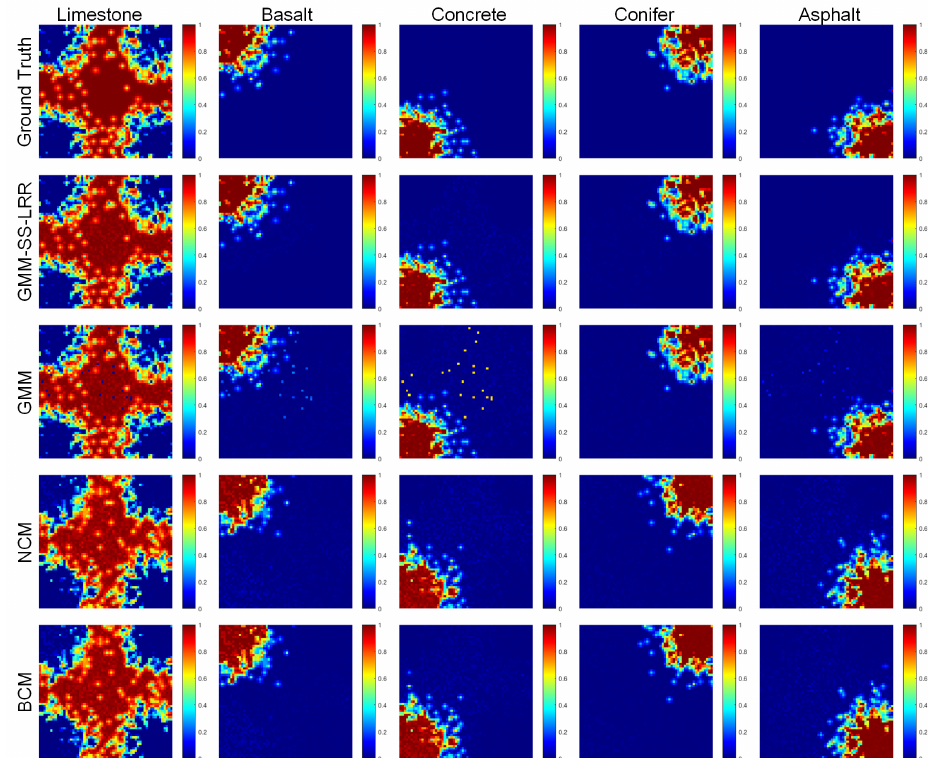
Figure 4. Abundance maps for the synthetic dataset. From top to bottom: Ground truth, GMM-SS-LRR, GMM, NCM, and BCM. The corresponding endmembers from left to right are: limestone, basalt, concrete, conifer and